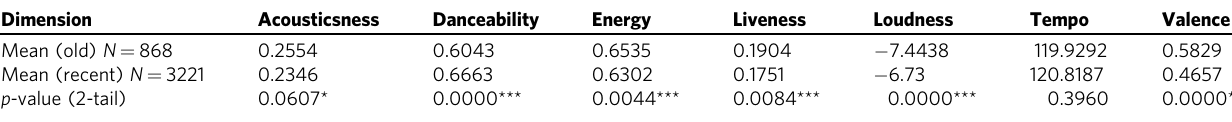
Table 3 Summary statistics of audio features of nostalgic and recent songs.